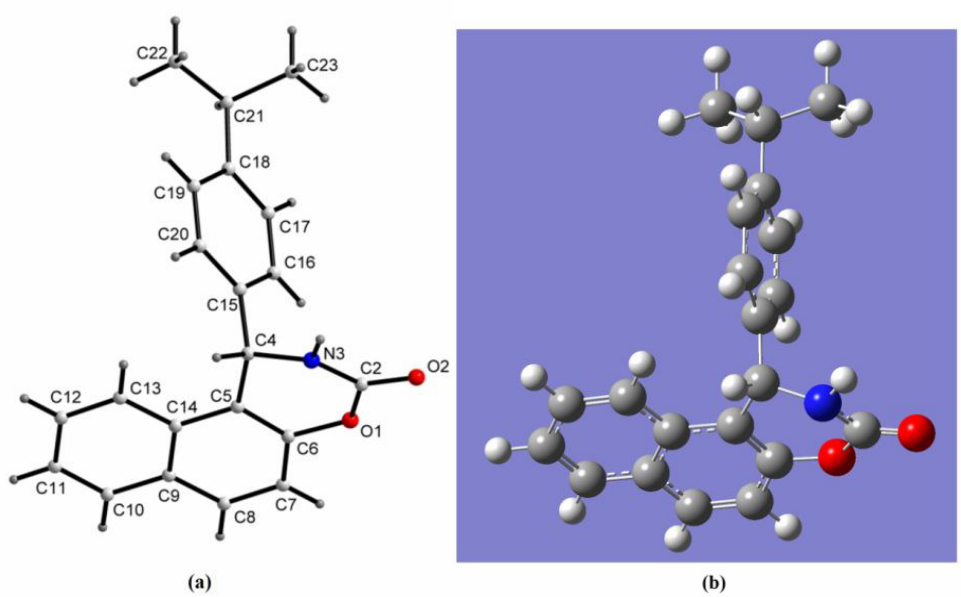
Fig. 1. (a) X-Ray crystal structure of (S)-enantiomer of 4i compound (displacement ellipsoids at 50% probability level), (b) Geometrical structure of the 4i compound (optimized at B3LYP/6-311+G*